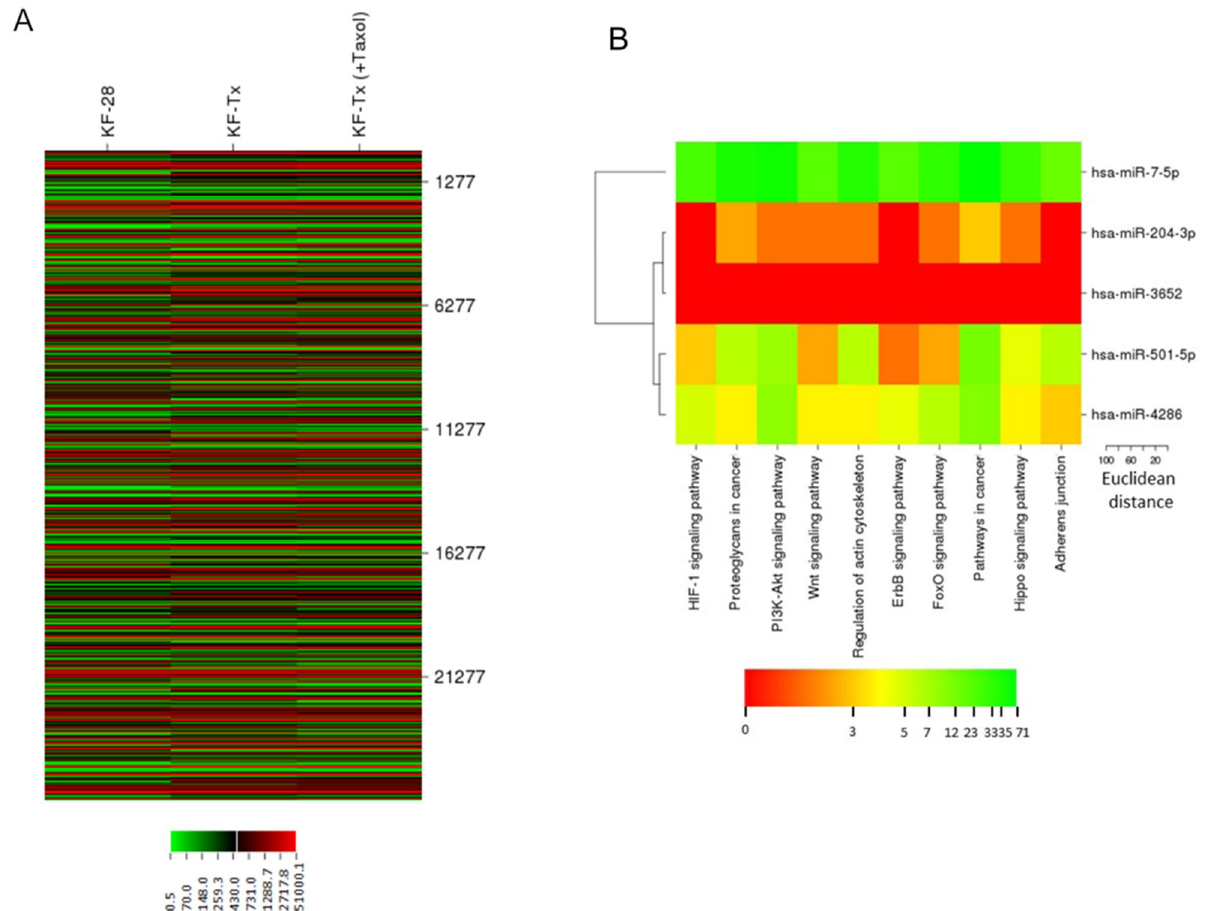
Figure 3. MRNA profiling of taxane responsive and taxane resistant OC cells. ( A ) Heatmap of a mRNA expression microarray analysis illustrating differential expression of genes in taxol-responsive cells (KF-28), taxol-resistant cells (KF-Tx) and KF-Tx cells treated with PTX. ( B ) Categorization of the miRNAs target genes and their pathways in KF-Tx before and after co-treatment with 5 ′ AZA and